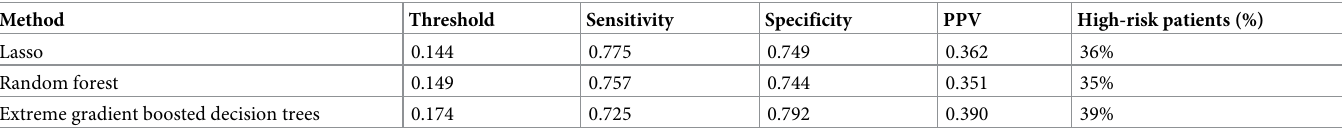
Table 3. Resulting threshold, sensitivity, specificity, and PPV for each of the 3 modeling methodologies for the composite outcome, any complication.